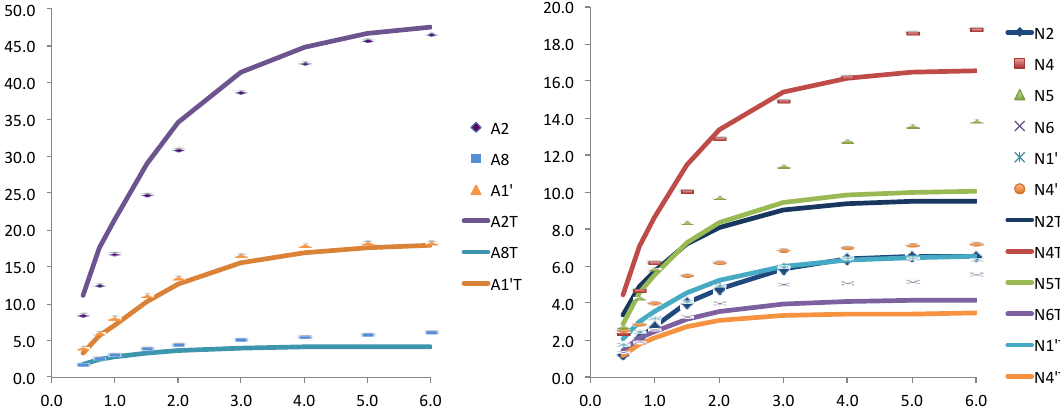
Figure 3. Relative STD experimental for WT Anabaena FNR and NADP + (dots) and theoretically predicted (lines) with CORCEMA for the crystallographic structure (PDB: